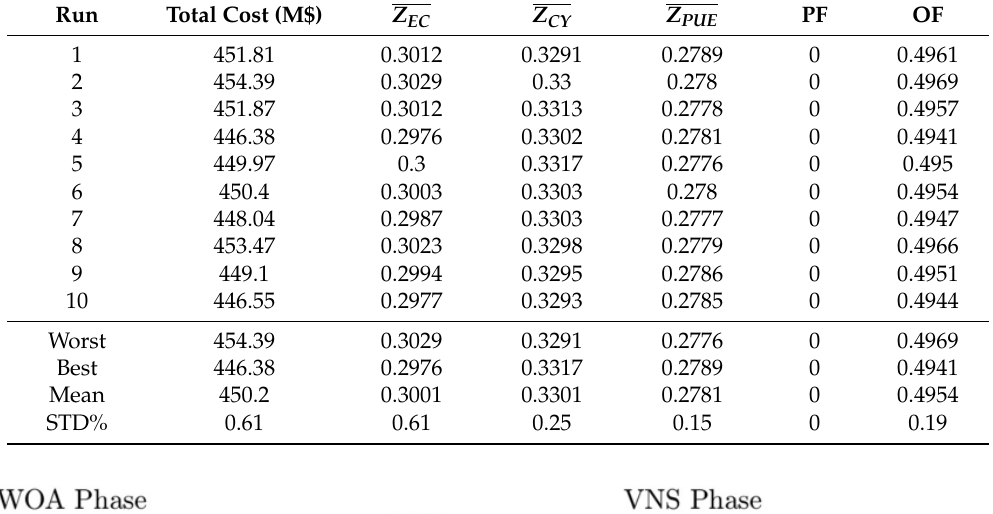
Table 8. Results of the H-WOA-VNS algorithm in 10 successive runs to solve the sustainable PFSCM model for the Case Study.